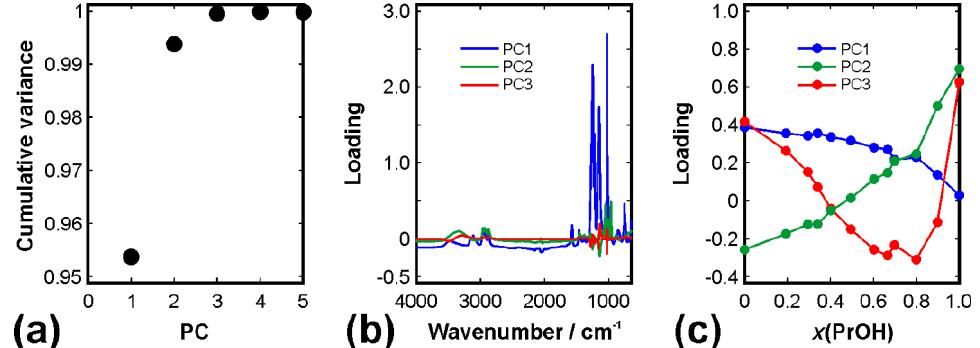
Figure 2. Principal component analysis (PCA) screening results of the FTIR data set: ( a ) cumulative variance of the first five principal components (PCs), ( b ) loadings spectra, ( c ) loadings as a function of composition.